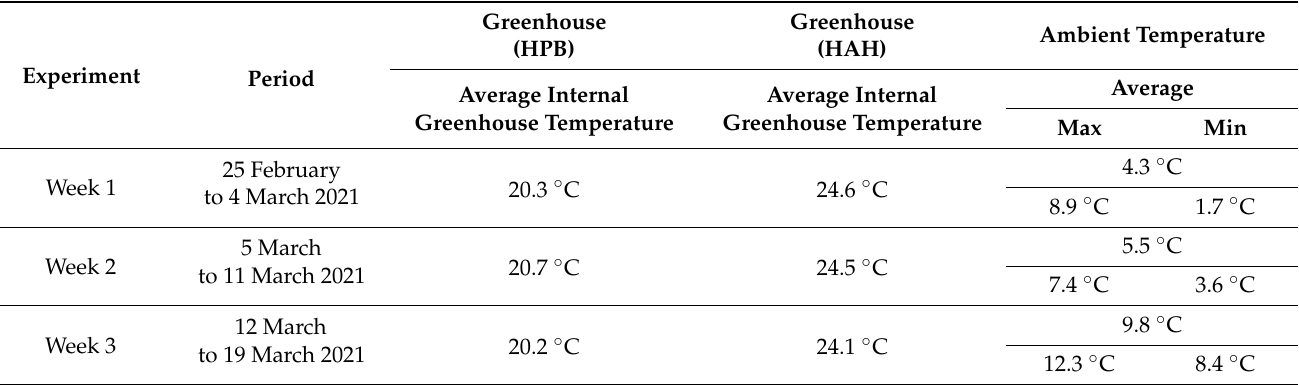
Table 9. Internal temperature of greenhouse and temperature lifting during the heating time (18:00 to